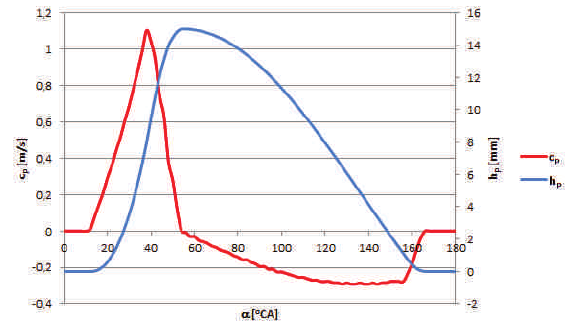
Fig. 7. Lift and velocity of plunger of the injection